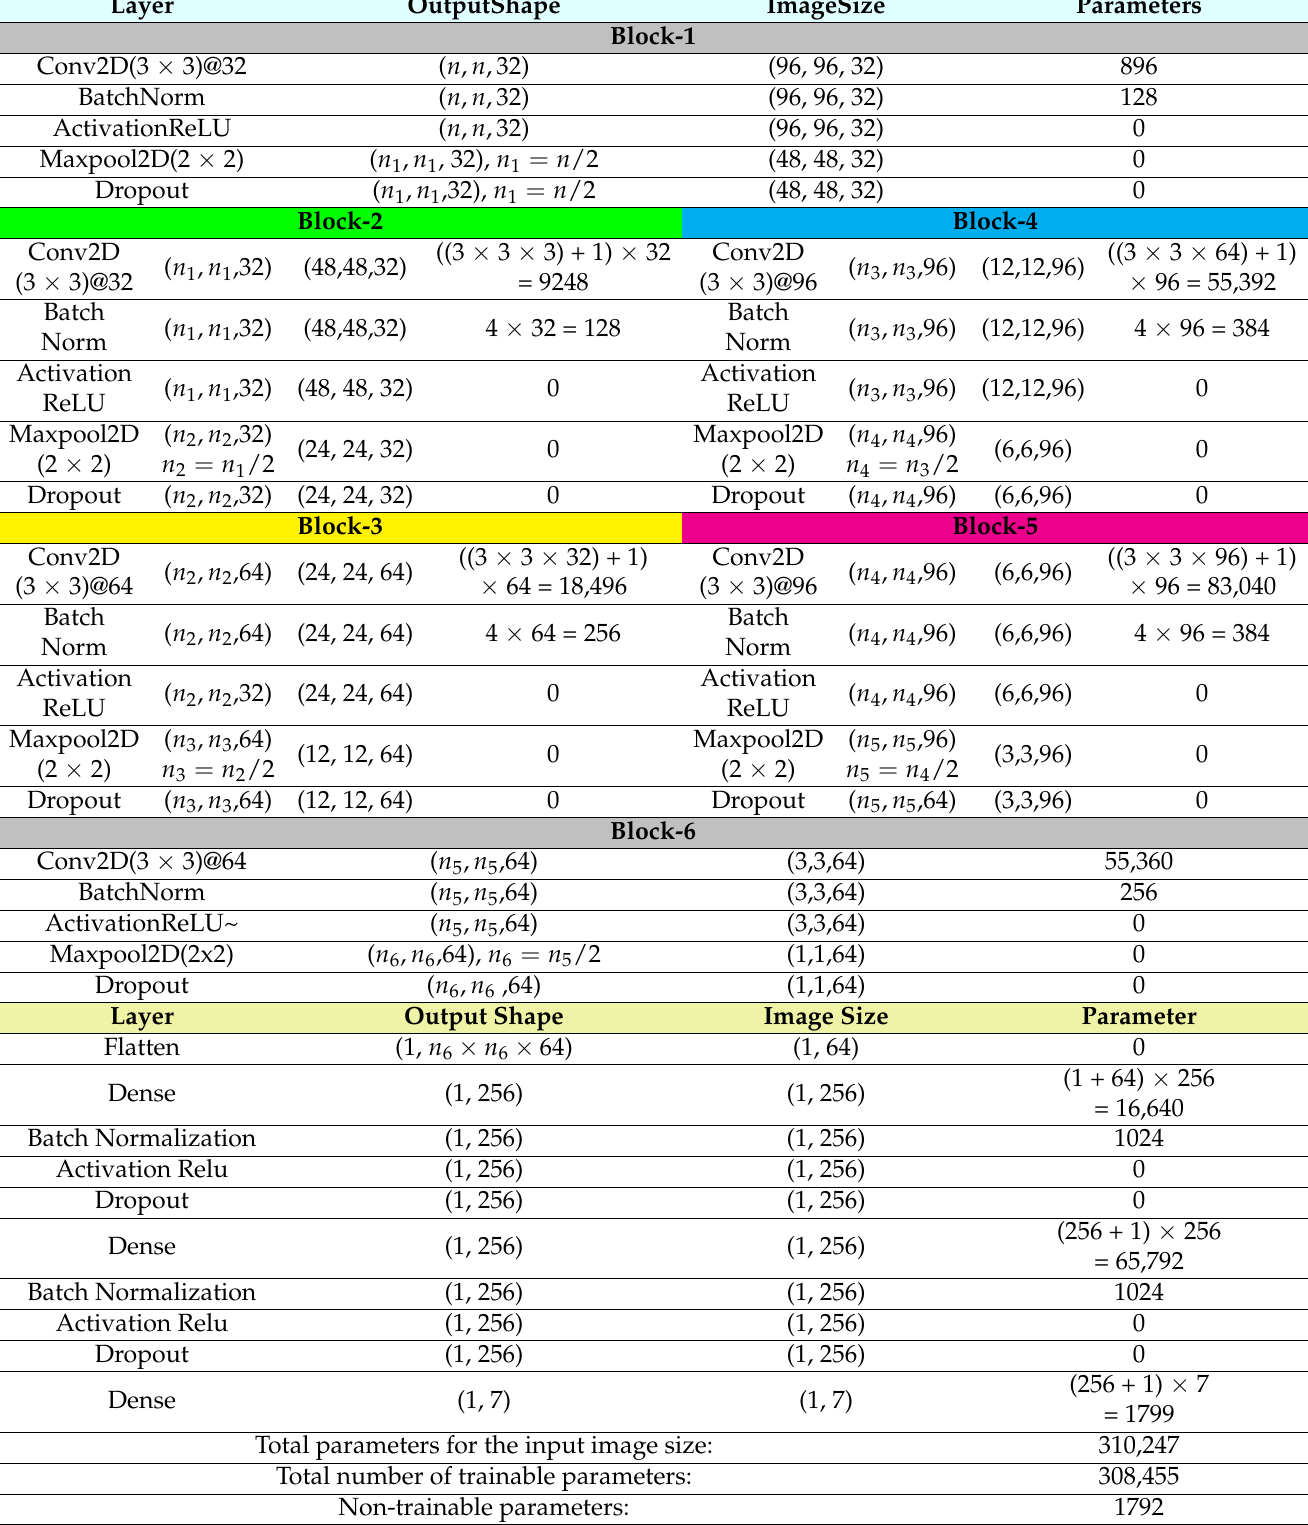
Table 2. The proposed CNN architecture for the input size 96 × 96 with layers, output shape, image size, and parameters. Layer OutputShape ImageSize Parameters